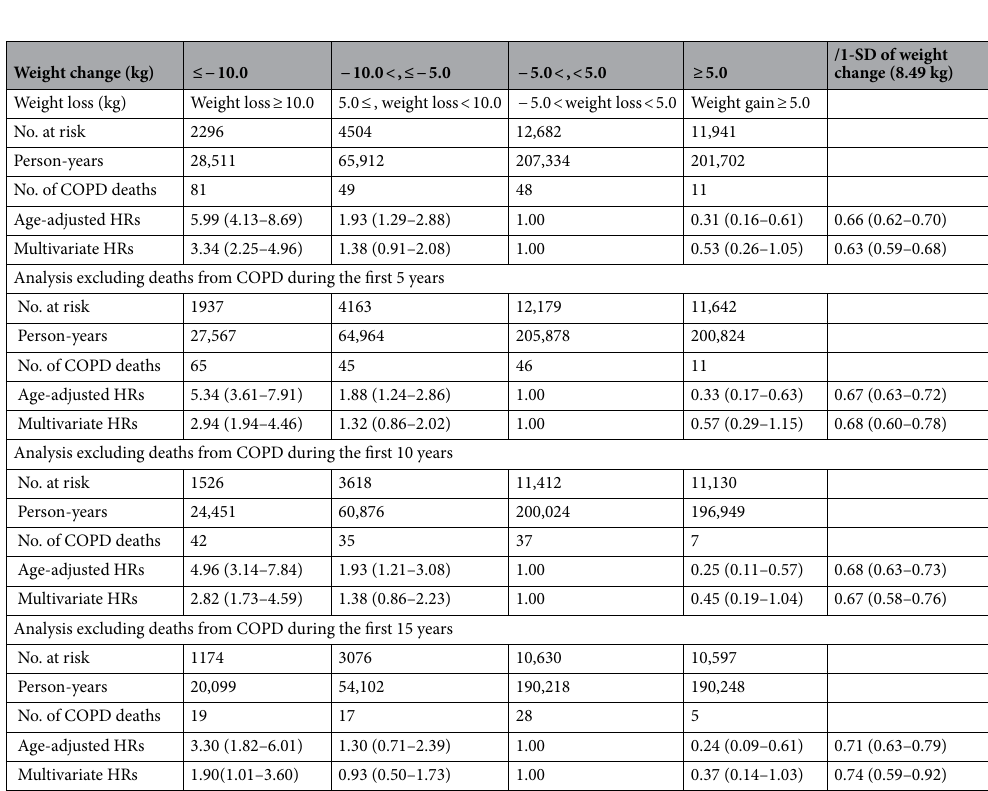
Table 4. Hazard ratios (HRs) and 95% confidence intervals of COPD mortality according to weight change from the age of 20. Multivariate adjustment for age, BMI, ethanol intake, hours of walking, hours of exercise, education history, smoking index, and disease